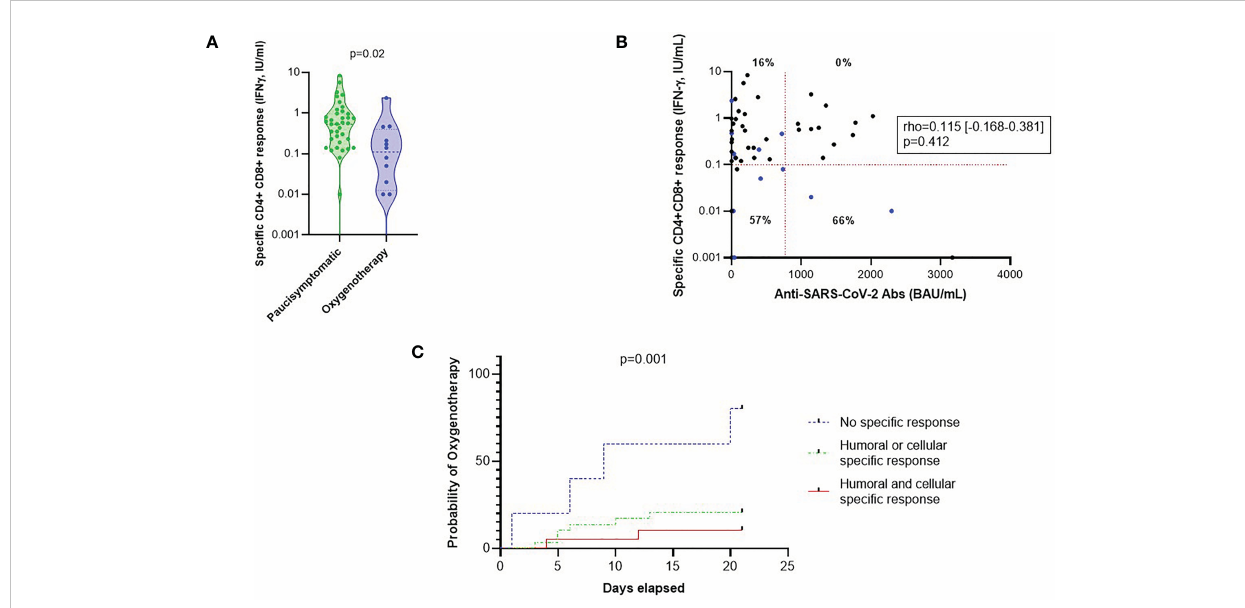
FIGURE 2 Speci fi c cellular and humoral responses post-vaccination and the risk of oxygen requirement after breakthrough SARS-CoV-2 infection. (A) Comparison of CD4 + CD8 + speci fi c responses according to oxygen requirement. Statistical signi fi cance of difference between groups was assessed using Mann-Whitney non-parametric test. (B) Correlation between CD4 + CD8 + speci fi c responses and anti-SARS-CoV-2 antibody titers (BAU/mL). Patients who required oxygen therapy are represented by blue dots, others by black dots. Percentages represent the rates of patients on oxygen therapy in each dial. The level of IFN- g after speci fi c CD4 + and CD8 + stimulation required for a protective response is represented by a horizontal red line (i.e. 0.10 IU/mL). The level of anti-SARS-CoV-2 Ab required for a protective response in this cohort is represented by a vertical red line (i.e. 760 BAU/mL). The association between humoral and cellular responses were compared using Spearman rank correlation coef fi cient. (C) Oxygen-free survival rate based on humoral and cellular responses. Patients with an anti-SARS-CoV-2 antibody level greater than 264 BAU/mL or who received preventive anti-SARS-CoV-2 mAb were considered to have a good humoral response. Patients with IFN- g level after speci fi c stimulation greater than 0.10 IU/mL were considered to have a good cellular response. The IFN- g threshold of 0.10 IU/mL was determined by ROC curve with which we made the choice to favor speci fi city (sensitivity 50% and speci fi city 85%). A reverse Kaplan-Meier curve and LogRank test analysis were made to study these data. IFN, interferon; mAb, monoclonal antibodies; ROC, receiver-operating